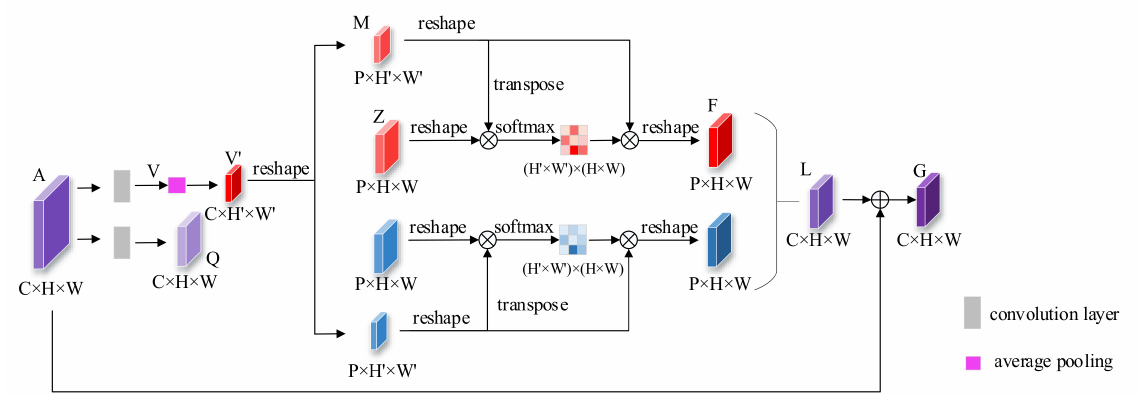
Figure 4. The structure of PA